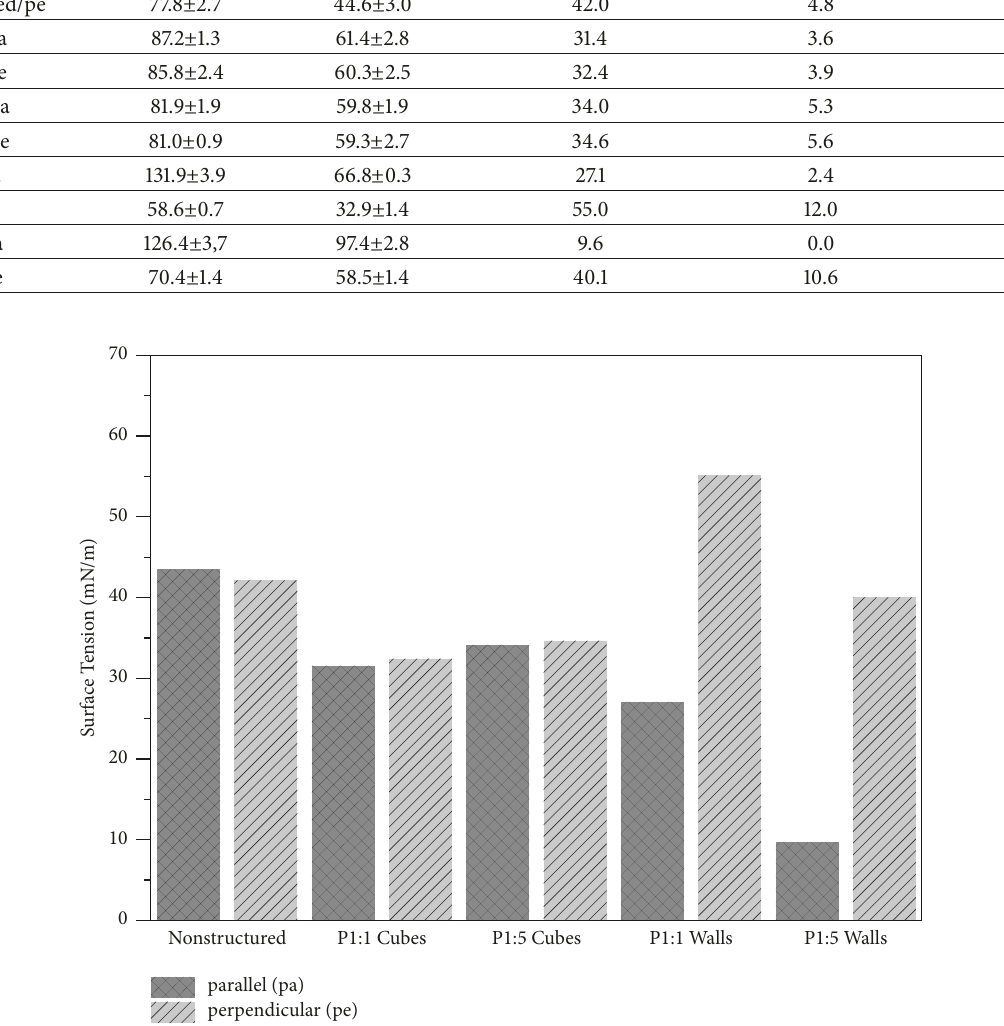
Figure 2: Surface tension depends on substrate topography. Calculated surface energy as function of substrate topography. Contact angles were measured perpendicular or parallel to nonstructured and specific surface